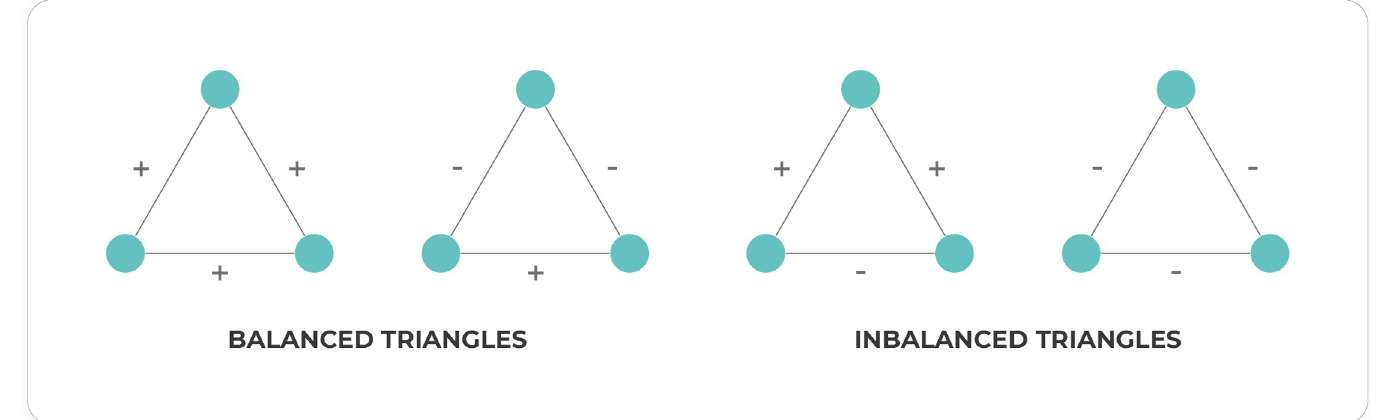
Fig 3. Classification of triad motifs according to structural balance theory. Balanced or imbalanced criterion is assigned according to their mutual correlations.